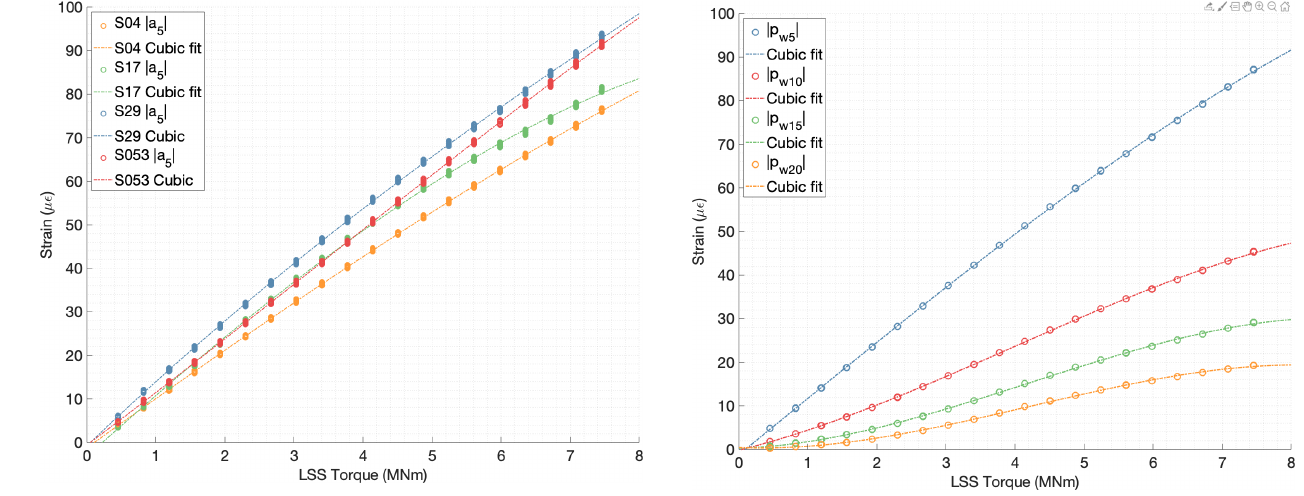
Figure 16. Magnitude of fifth harmonic | a 5 | of four strain sensors S04, S17, S29, and S53 vs. torque in low-speed shaft.